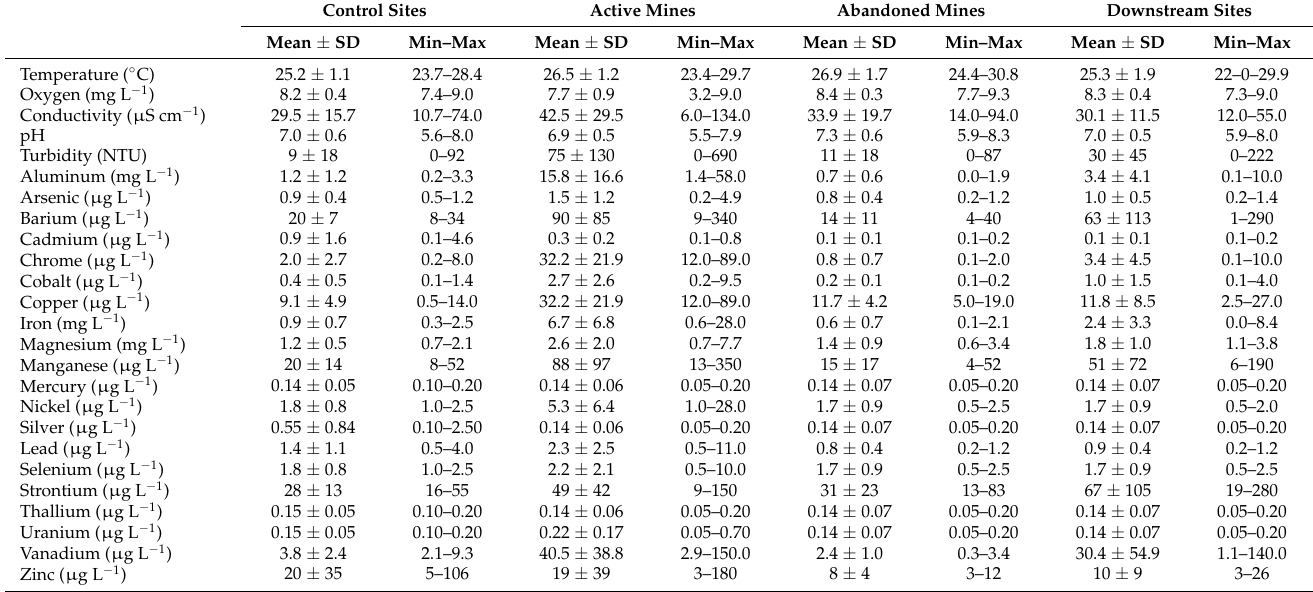
Table A1. Mean, standard deviation and range of variation of physical and chemical variables and heavy metal concentrations at the study sites.